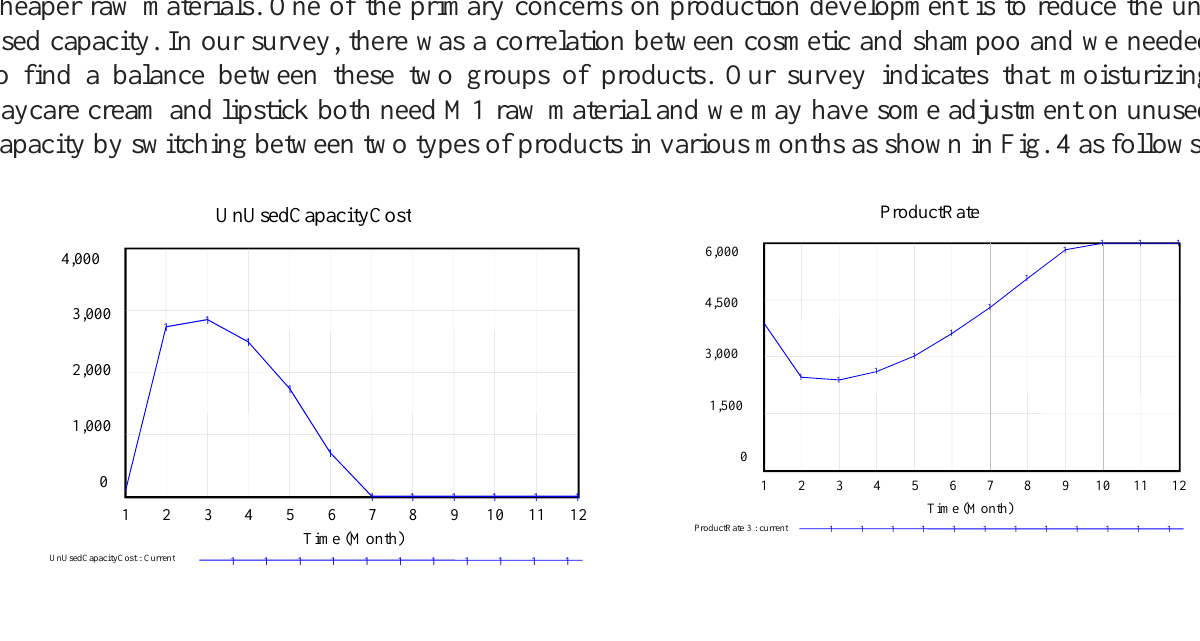
Fig. 4. The trend for unused capacity and production rate